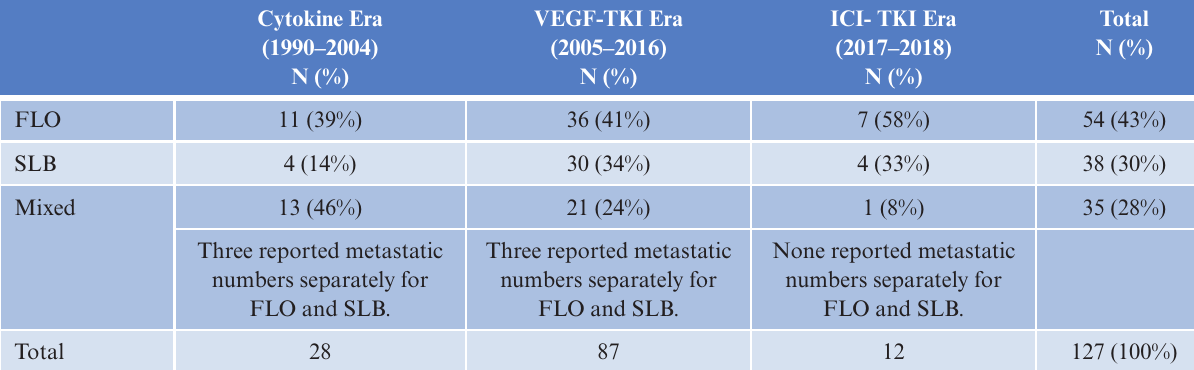
Table 1: Included studies based on the treatment eras. Cytokine Era